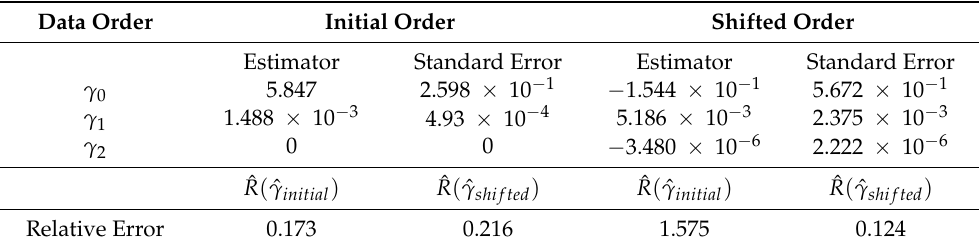
Table 2. Resulting HPC estimates and standard error of correlation components γ , under initial and shifted order, respectively. Relative errors between sample and estimated correlation under different orders are cross